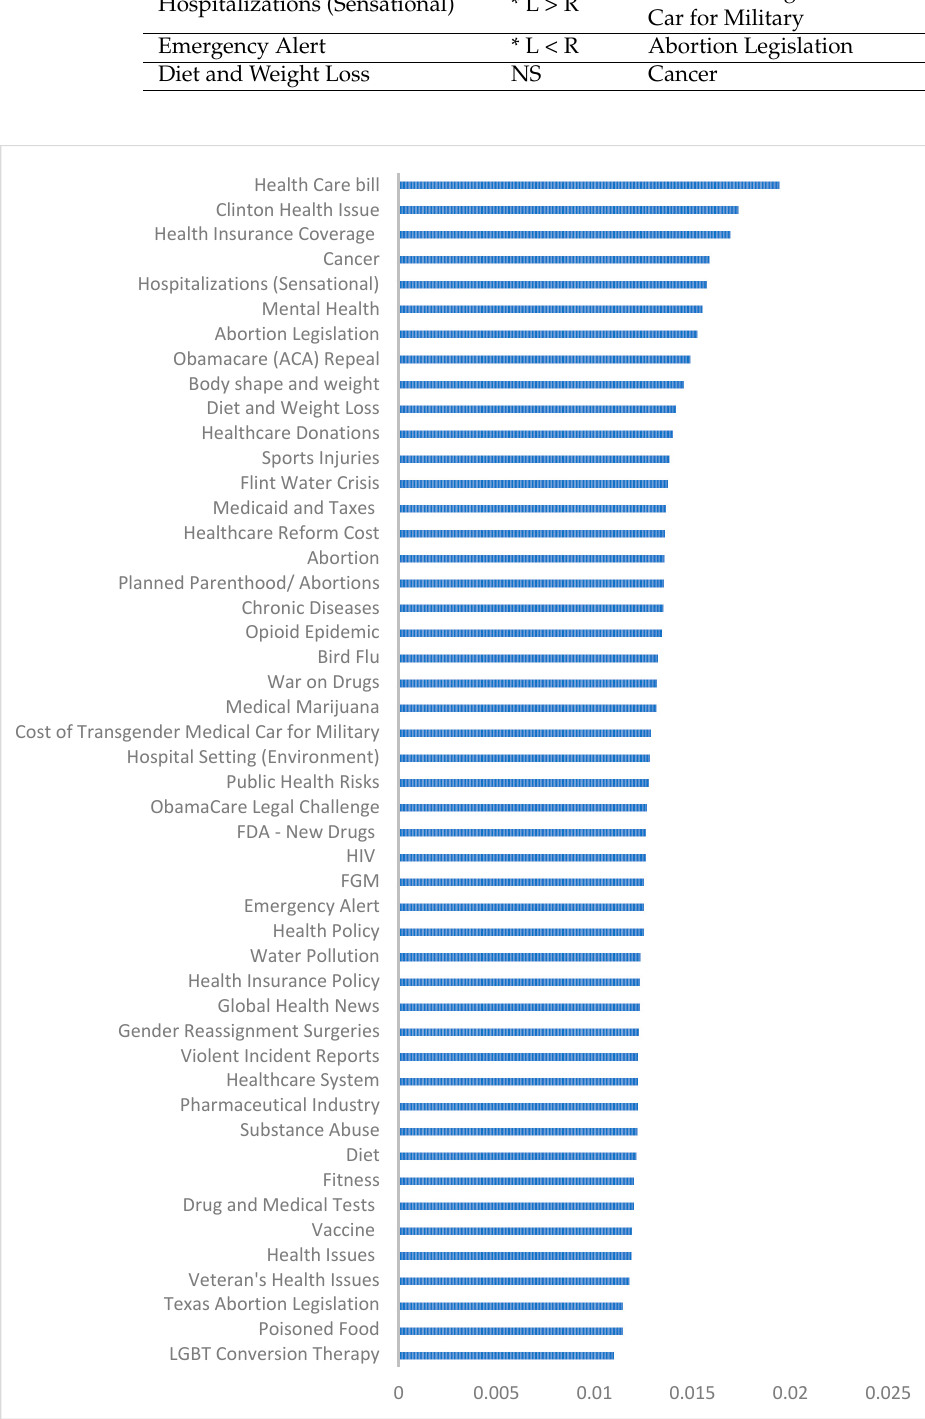
Figure 4. Overall weight of topics.